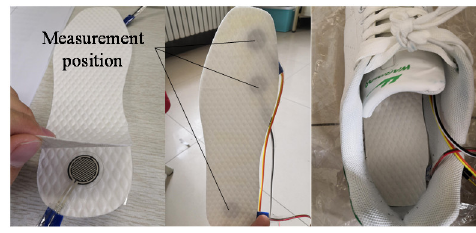
Figure 4. Position of pressure sensors.